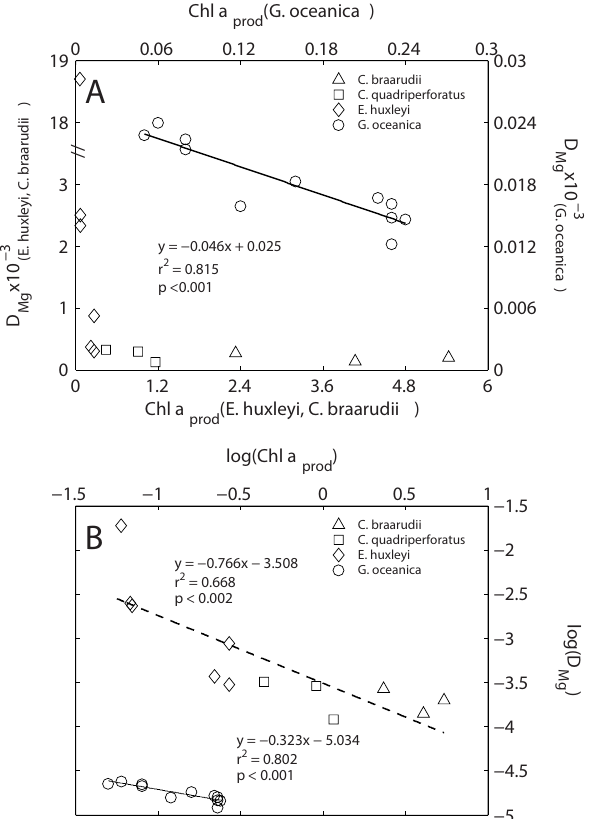
Fig. 4. Magnesium partition coefficient ( D Mg ) as a function of chlorophyll a production rates (A) , black line indicates linear re- gression through data points of G. oceanica at 20 ◦ C. (B) The log- transformed data of (A) to illustrate the linear correlation in the combined data of E. huxleyi , C. braarudii and C. quadriperforatus (dashed line). The solid line in (B) indicates the linear correlation through data points of G. oceanica at 20 ◦